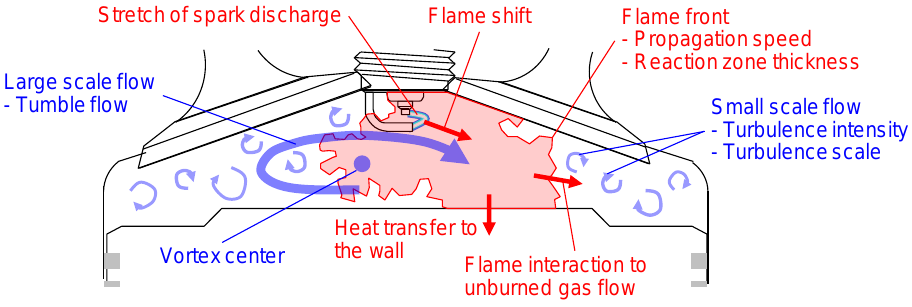
Figure 1. Flow-field, flame propagation, and its interaction in a spark ignition engine.